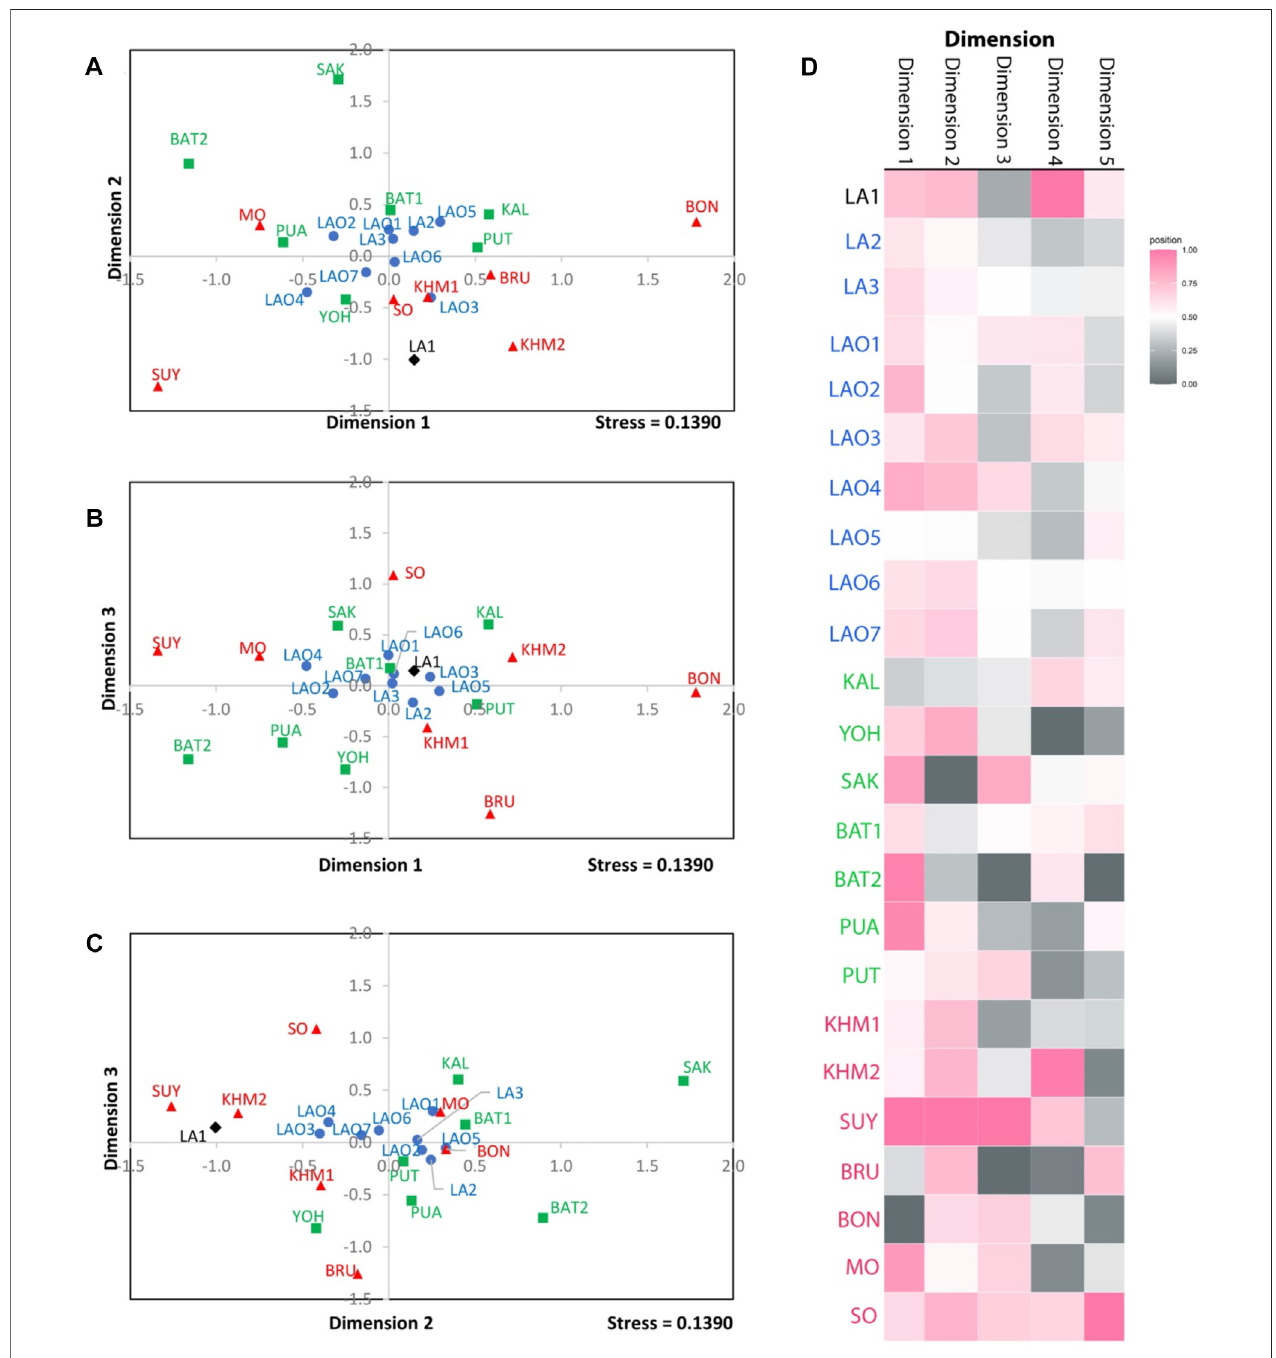
FIGURE 6 | The three-dimensional MDS plots of dimension 1 vs. 2 (A) , 1 vs. 3 (B) and 2 vs. 3 (C) of total 24 populations. The heat plot of standardized values of MDS with fi ve dimensions (D) . Black diamond, blue circles, green squares, and red triangles represent AA-speaking Laotian, ethnic Lao group, compared TK-speaking and AA-speaking populations